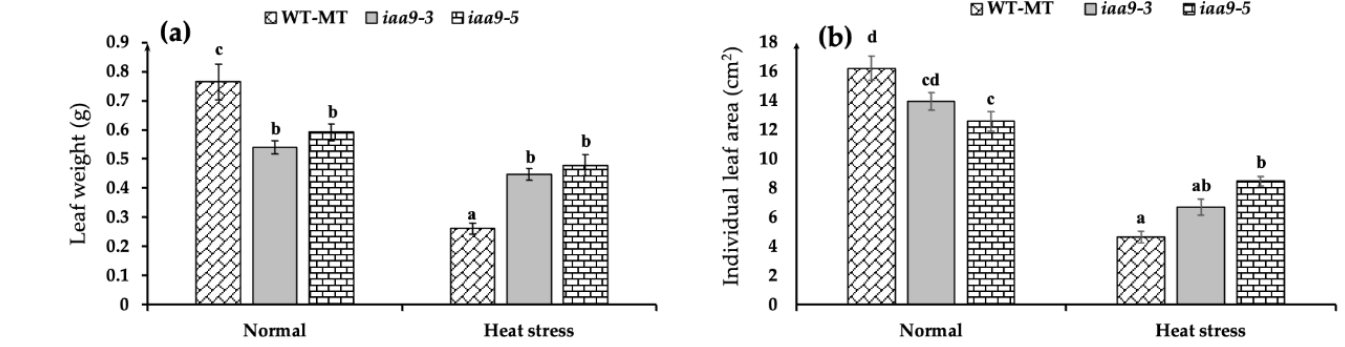
Figure 1. ( a ) Leaf weight of WT-MT, iaa9-3 , and iaa9-5 under normal and heat stress conditions; ( b ) individual leaf area of WT-MT, iaa9-3 , and iaa9-5 under normal and heat stress conditions. The average value ± standard error (SE) ( n = 4) followed by the same letter is not significantly different according to the Tukey-HSD test at 5%.